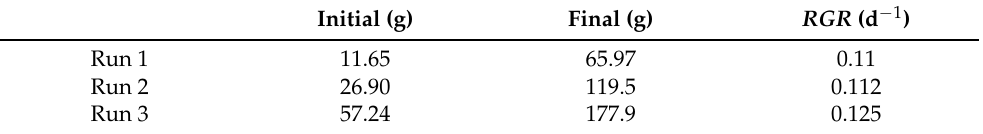
Table 1. Starting biomass and final biomass measurements for batch runs: Run 1, Run 2 and Run 3. Initial